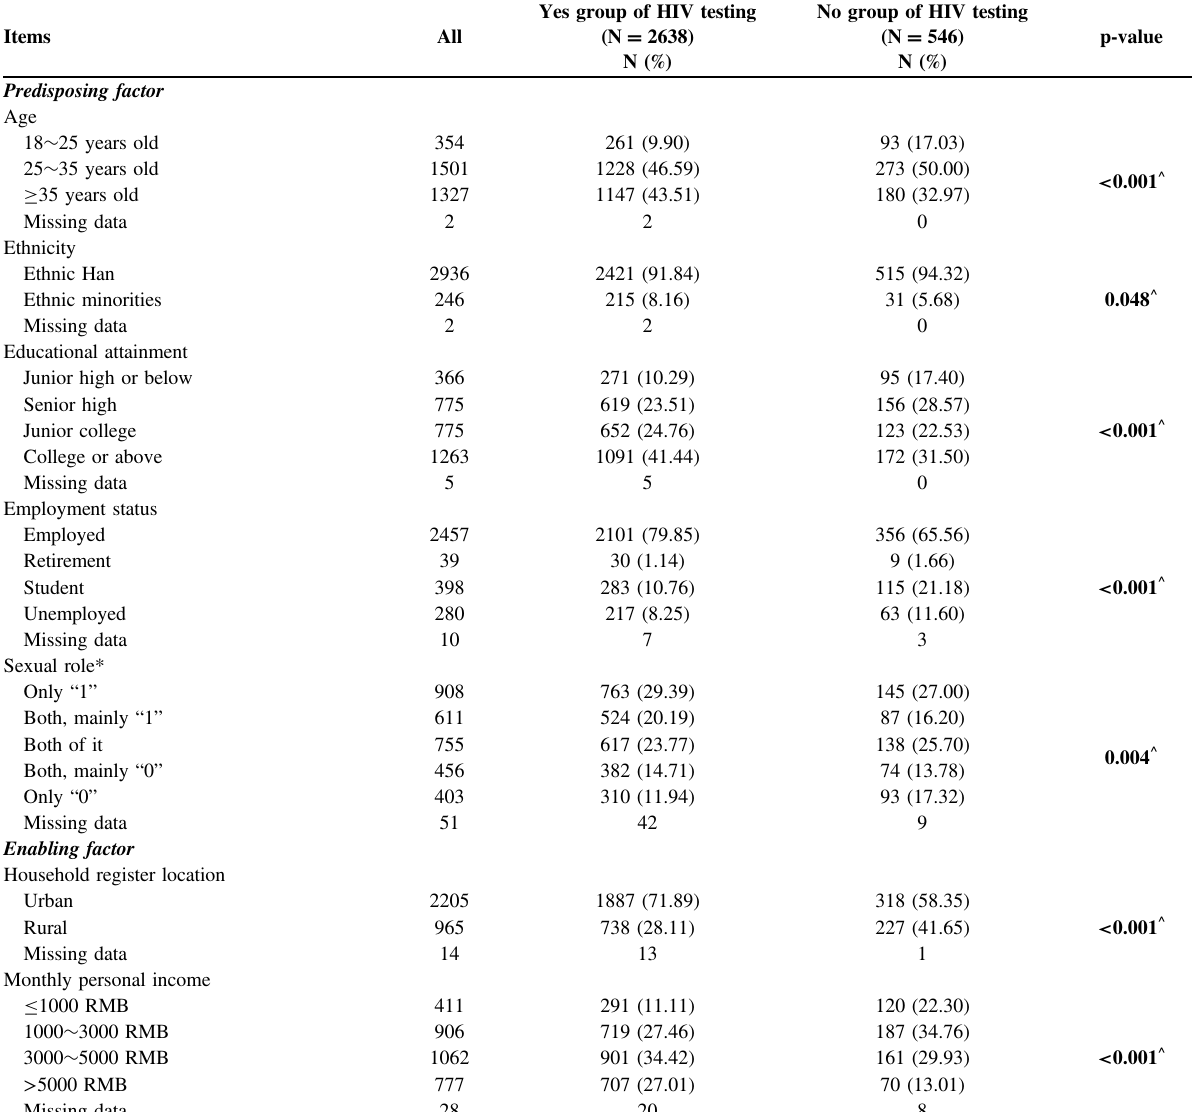
Table 1 Univariate analysis of HIV testing service (N =